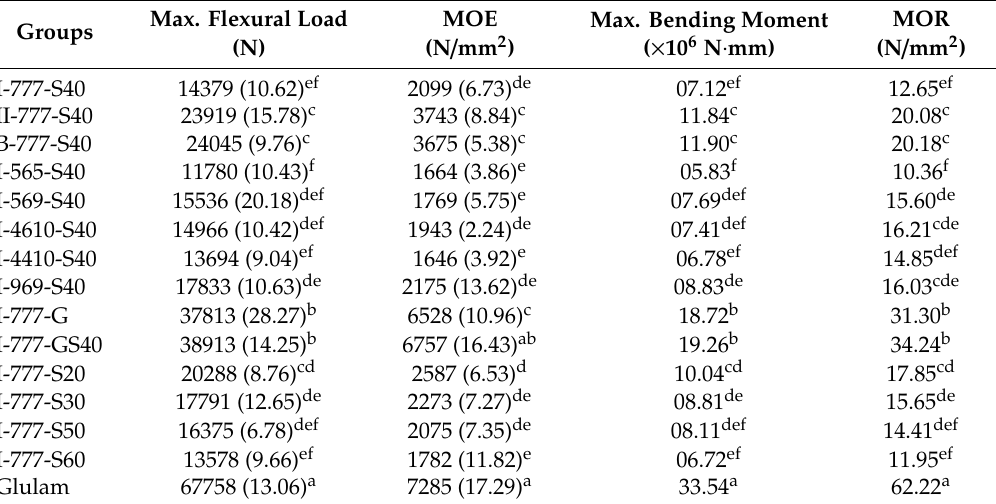
Table 2. Flexural properties of the developed built-up